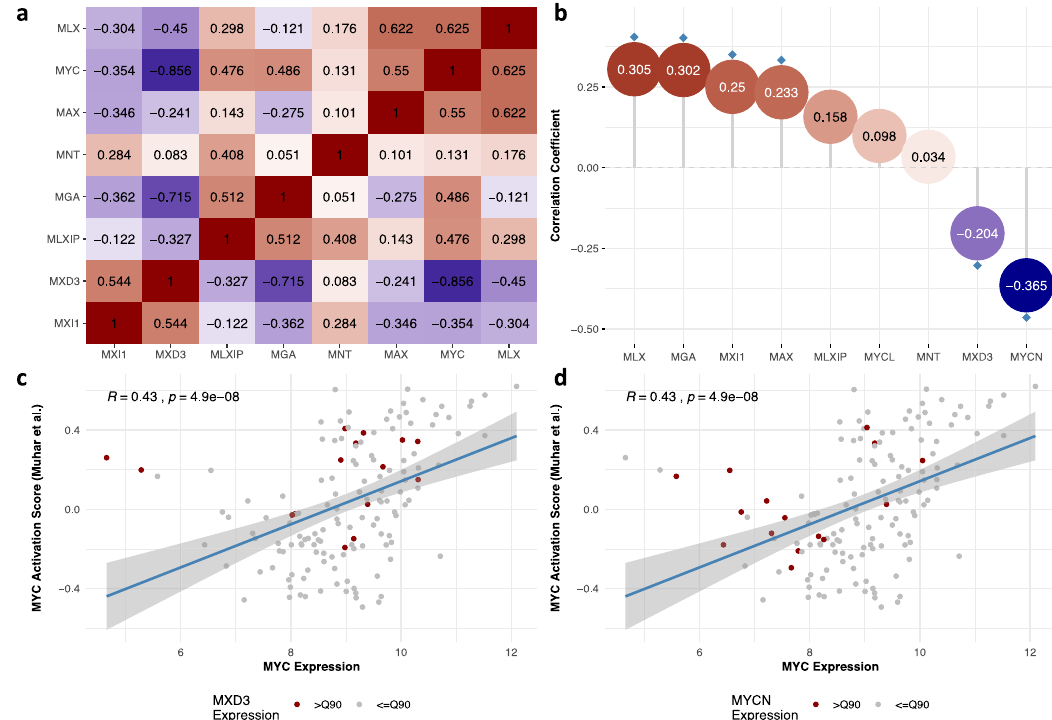
Fig. 5 Expression analysis of proximal MYC network members. a Heatmap showing the correlation structure of the proximal MYC network members in IBC cell lines. The proximal MYC network members are indicated along both X- and Y-axes and ordered similarly based on the output of a Ward clustering analysis. Correlations are coded according to a blue-red coloring scheme representing negative to positive correlation coef fi cients respectively. Correlation values are provided in the corresponding cells. b MYC correlation analysis for the proximal MYC network members in a series of 146 IBC patient samples. The proximal MYC network members and strength of the correlation between their expression and MYC mRNA levels are shown along the X- and Y-axis respectively. Each correlation coef fi cient is indicated by a dot, coded according to a blue-red coloring scheme representing negative to positive correlation coef fi cients respectively and correlation values are provided inside. Signi fi cant values are indicated with a blue diamond. c , d Scatter plots comparing MYC expression (X-axis) and MYC transcriptional activity (Y-axis) calculated according to the gene set published by Muhar et al. in a series of 146 IBC samples. Each sample is represented by a point, which is colored red if the corresponding sample is characterized by MXD3 ( c ) or NMYC ( d ) expression values exceeding the 90th percentile. A regression line depicting the linear relationship between MYC expression and transcriptional activity is indicated and results of the Spearman correlation analysis are provided in the top left